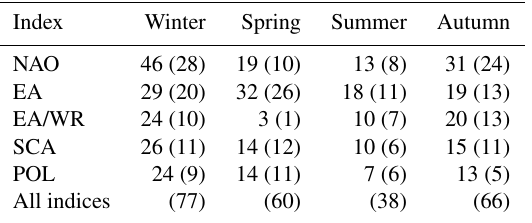
Table 1. Percentage of stations with climate-informed fits preferred to the classical GEV distribution model. Indicated is the result of the pairwise comparison of each covariate with the classical model and the percentage of preferred fits for each covariate when all models are compared (in brackets). Results are shown per season and for mean seasonal covariates.